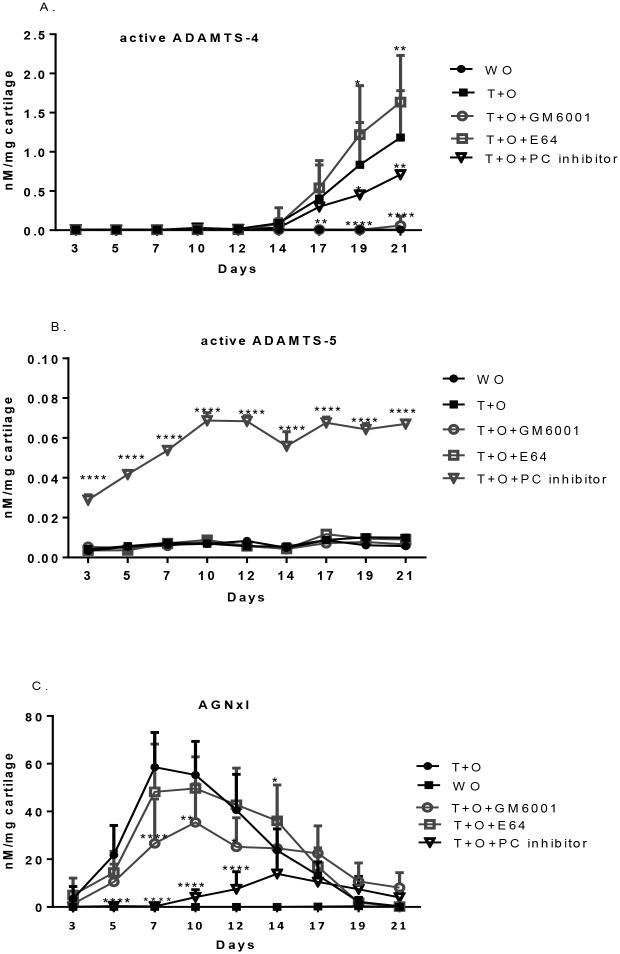
The effect of broad-spectrum inhibitors on the profiling of active aggrecanases and their specific aggrecan degradation fragments.(A) active ADAMTS-4. (B) active ADAMTS-5. (C) AGNxI. All values were shown as mean±95% confidence intervals (n = 8 in each group). Error bars indicated the upper limit of 95% confidence intervals.